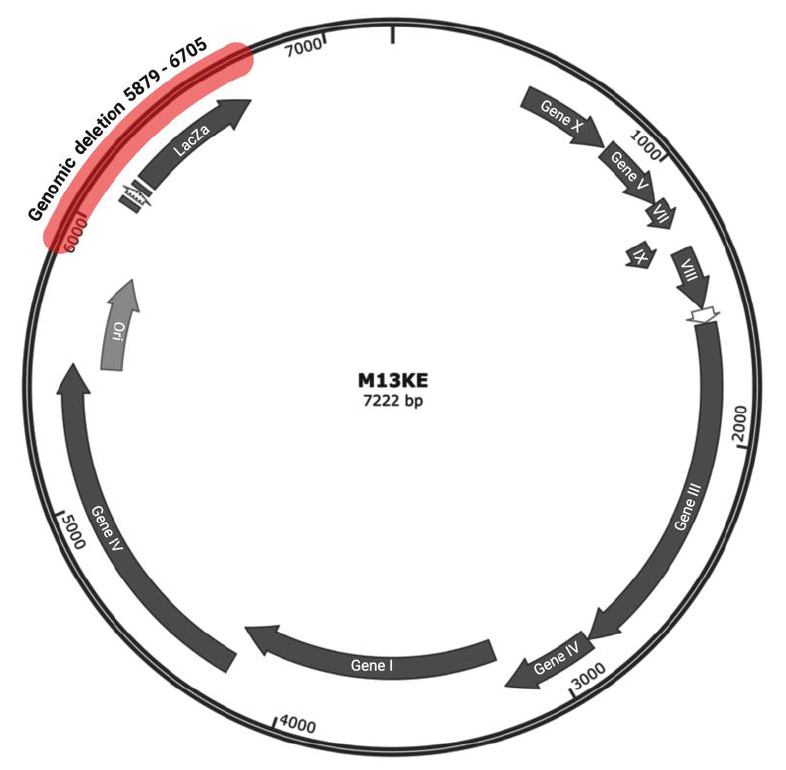
Figure 4. Schematic representation M13KE genome indicating large intergenic deletion (red) revealed by whole genome sequencing. The deletion was detected in positions 5879–6705 (827 nucleotides), causing deletion of the segment encoding lacZ α gene. The M13KE genomic information was down- loaded from New England Biolabs repository [12] and the figure was prepared using SnapGene and BioRender. Table 1. White/blue plaque count-based titration in competitive propagation assay. The increased titer of white plaques is significantly higher than blue plaques during amplification period. Ratio was obtained through dividing the titer of white plaques by the titer of blue plaques at each time point. Percent is calculated by dividing the titer of white plaque by the titer of both white and blue plaques multiplied by